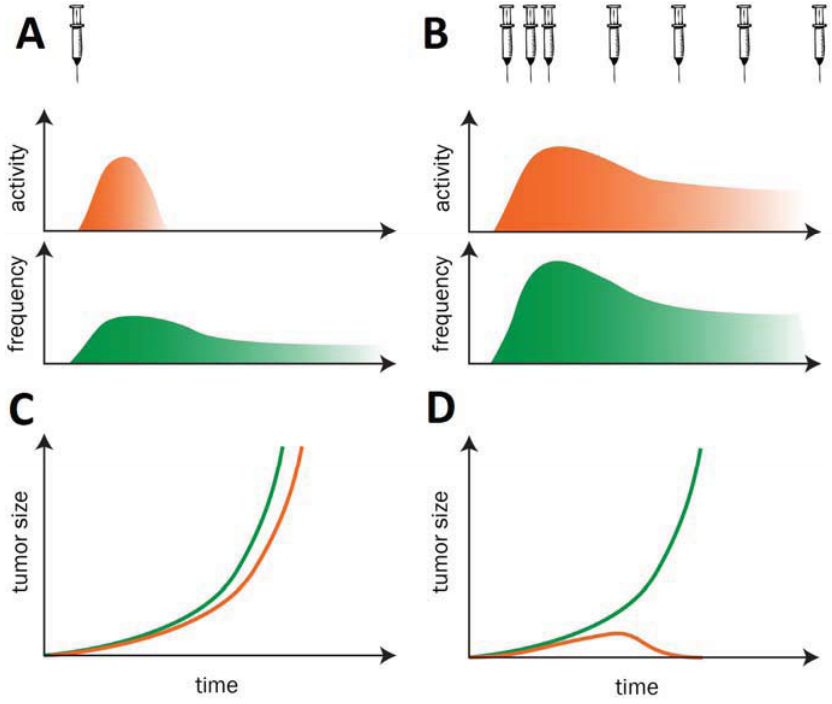
Figure 1. Activity of cancer vaccines: relationship between vaccine immunogenicity (activity and frequency of immune cells), repeated administration and antitumor